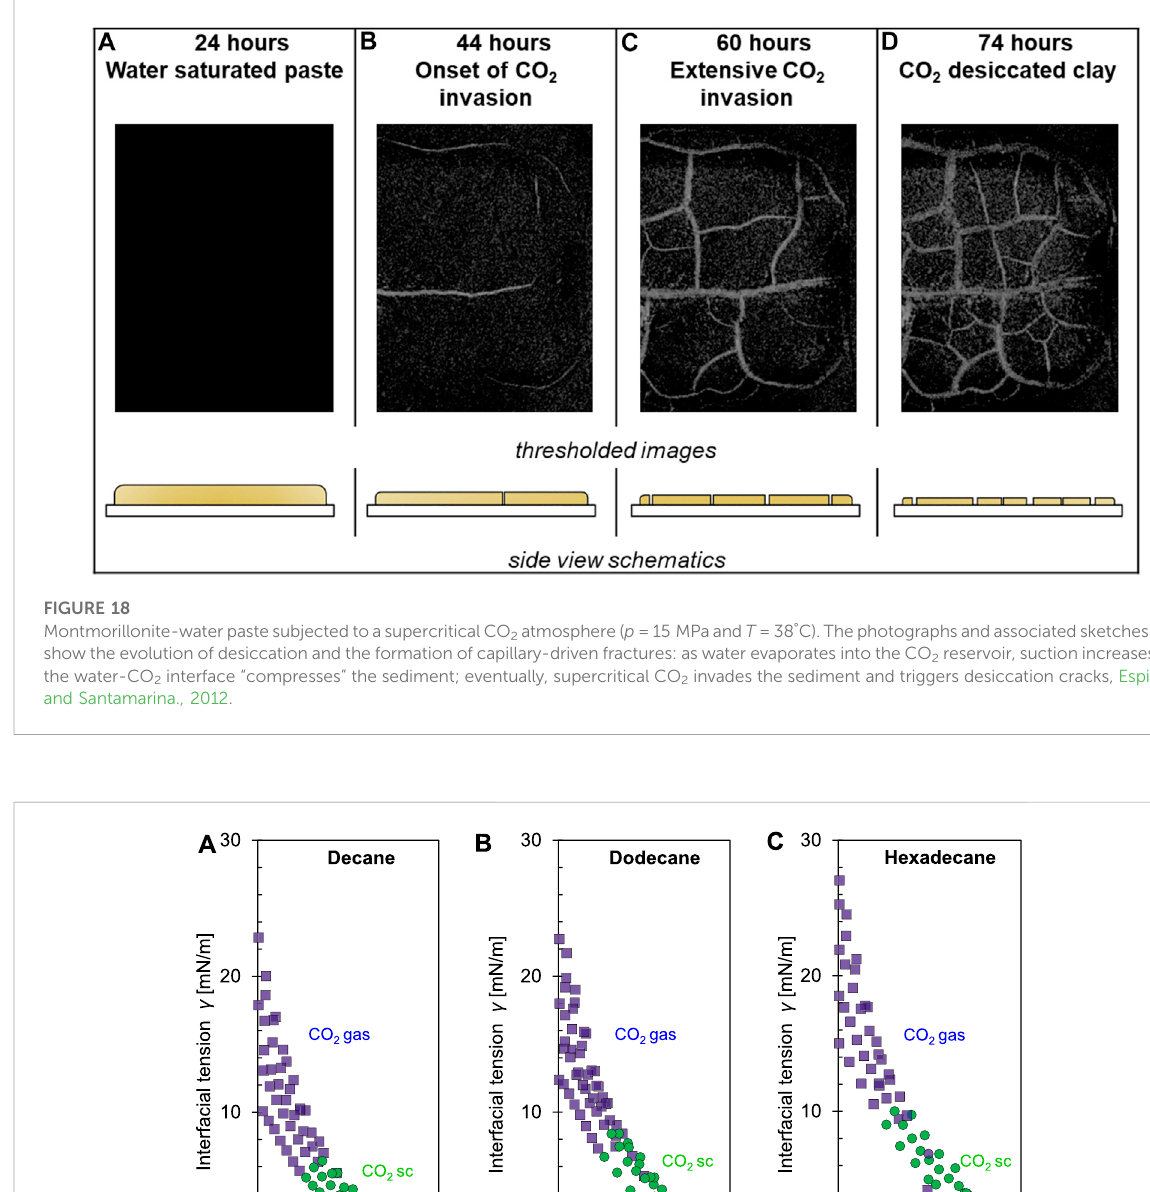
FIGURE 19 Interfacial tension between selected alkanes and CO 2 as a function of the CO 2 density at different pressures and temperatures: (A) Decane, (B) Dodecane and (C) Hexadecane. Symbols: CO 2 gas ( ■ ) and CO 2 supercritical ( C ). Data source: Georgiadis et al.,